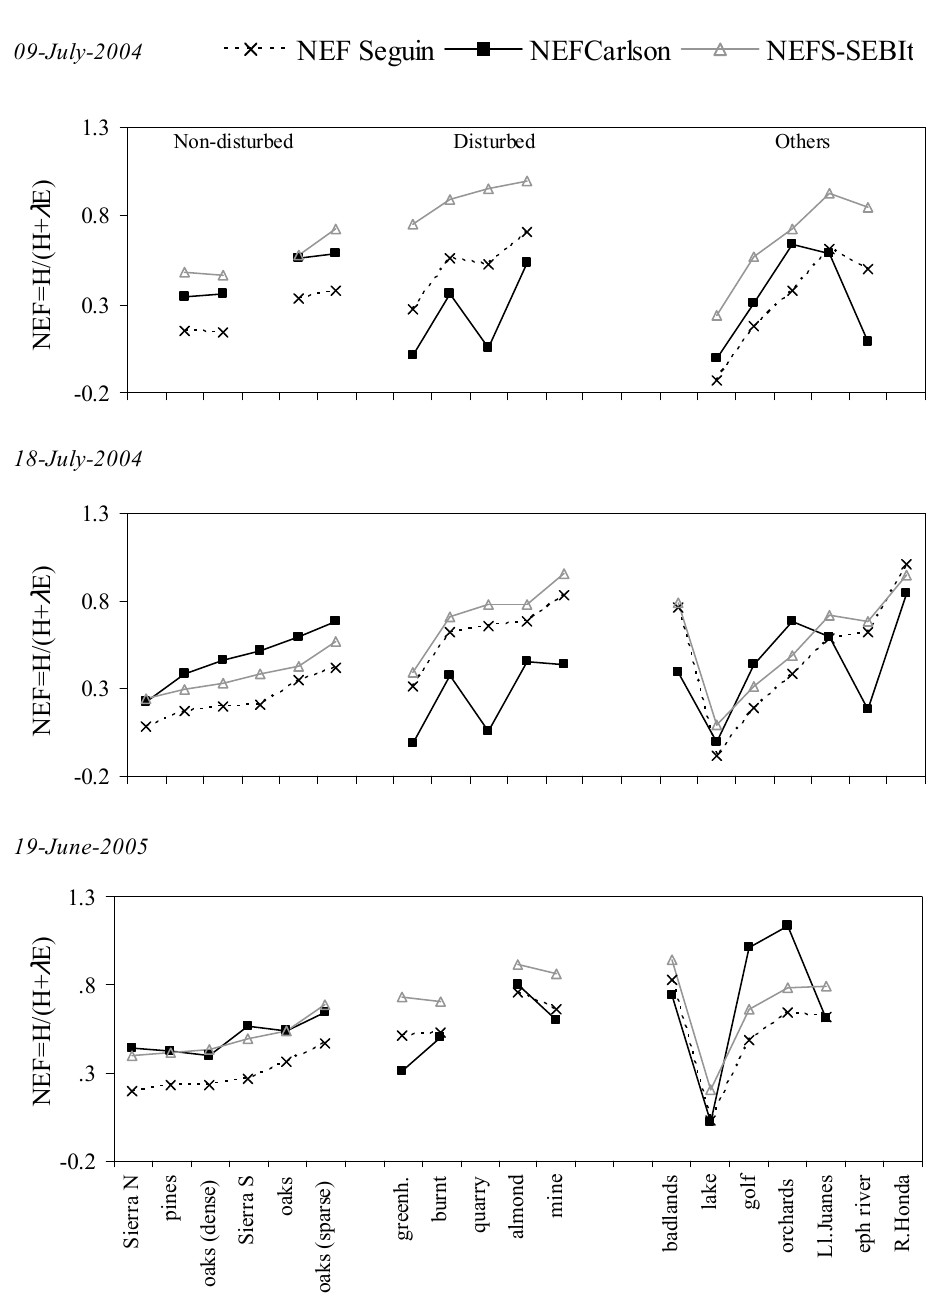
Figure 4. NEF (non-evaporative fraction) over selected surface types calculated by the NEF , NEF and NEF models. The first set of surfaces corresponds to undisturbed sites. Seguin Carlson S-SEBIt Sierra N and Sierra S are pine forests on the northern and southern slopes of the Sierra Nevada Mountains, three densities of oak relicts correspond to: oaks (dense), oaks (sparse) and oaks. Pines correspond old reforested sites. The second set is for disturbed sites: greenhouses (Greenh), a strong burn scar (burnt), a limestone quarry (quarry), almond orchards (almond), and an abandoned mine (mine). The third set comprises miscellaneous sites: the Tabernas badlands, a lake, a golf coarse (golf), irrigated citrus orchards along the Andarax River (orchards); Ll. Juanes is the Llano de los Juanes , eph.river is the ephemeral Andarax River and R.Honda is the Rambla Honda research